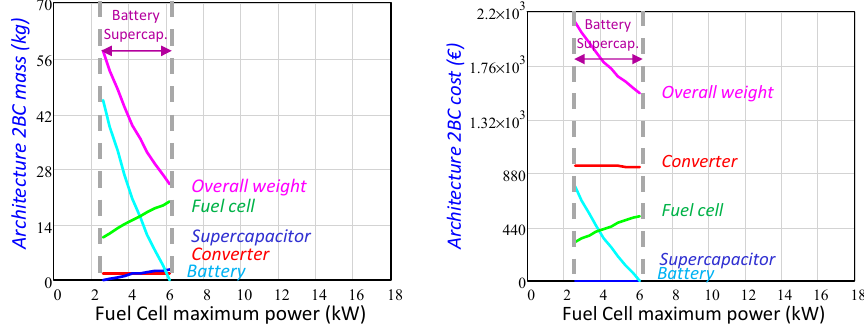
Figure 16. Architecture 2BC mass and cost.